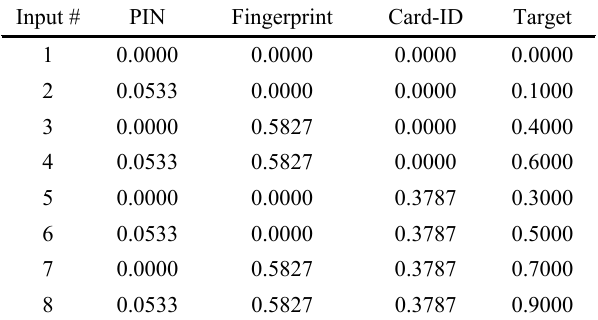
Table 4: Eight combinations of entropy identity attributes metrics input values and the corresponding target values.